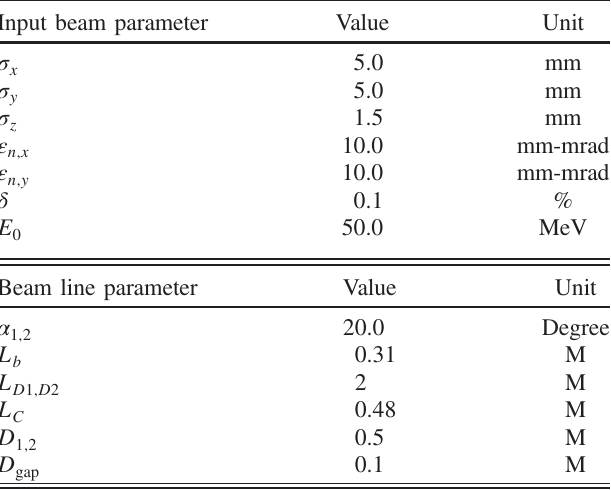
TABLE II. Input beam parameters and beam line parameters. Input beam